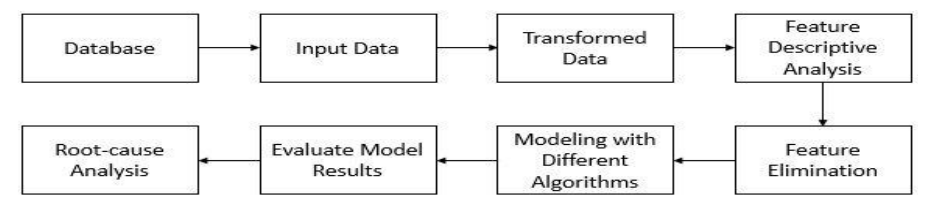
Figure 4. ML analytical process.